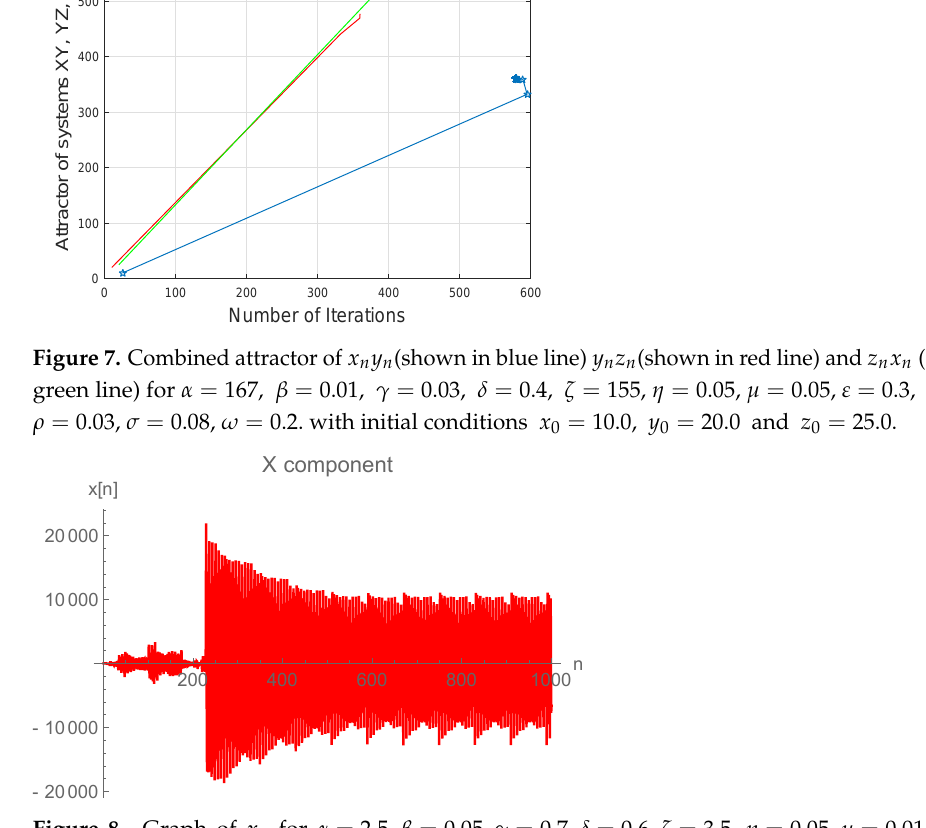
Figure 8. Graph of x n for α = 2.5, β = 0.05, γ = 0.7, δ = 0.6, ζ = 3.5, η = 0.05, µ = 0.01, ε = 4.1, υ = 0.09, ρ = 0.02, σ = 0.04, ω = 0.06. with initial conditions x 0 = 0.1, y 0 = 0.02 and z 0 = 0.04.